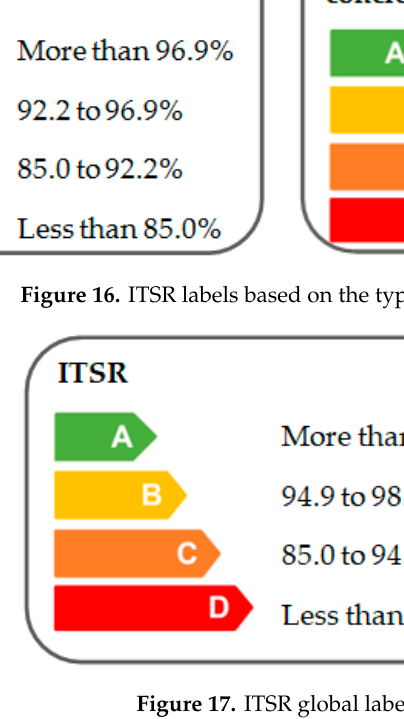
Figure 17. ITSR global label.